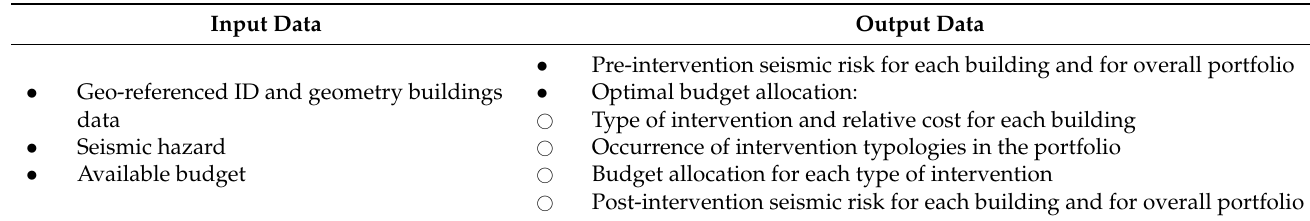
Table 2. Summary of input and output data of the decision-making tool.